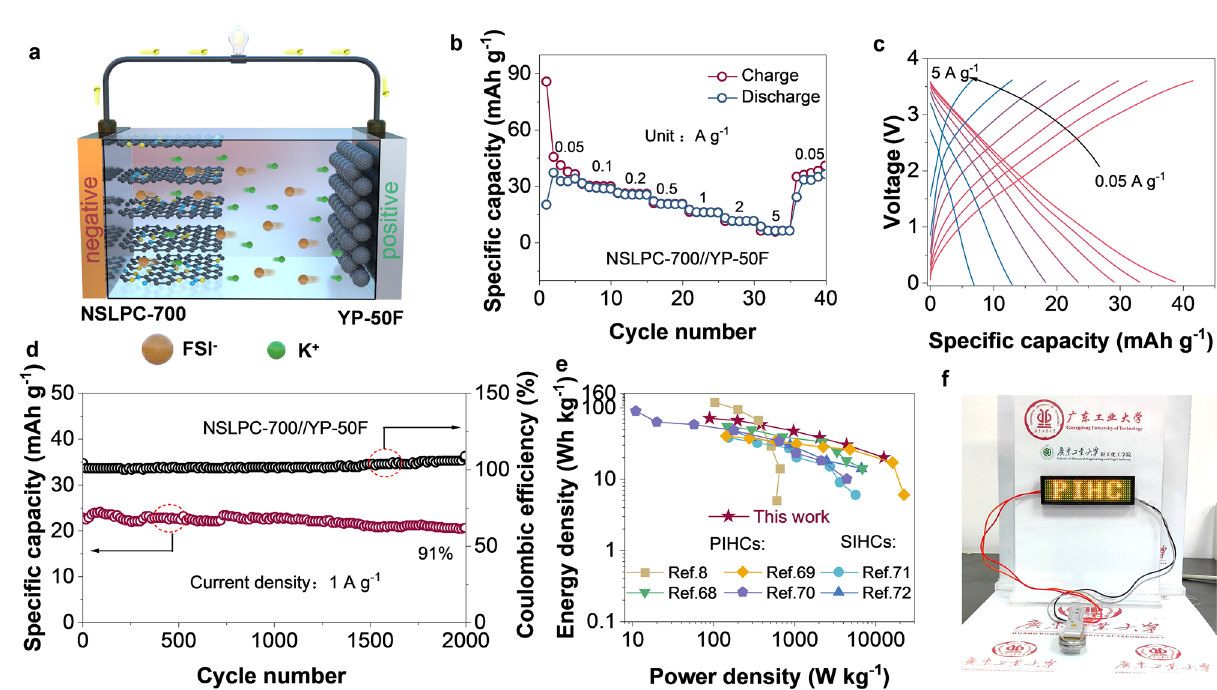
Fig. 8 The performance of PIHC. a Schematic illustrating the configuration of the PIHC (NSLPC-700//YP-50F) device. b Rate performance, and c GCD curves at different current densities. d Long-term cycle performance at 1 A g −1 . e Ragone curves of the NSLPC-700//YP-50F PIHC compared with other PIHC reported recently. f A digital photograph showing an LED bulb is powered by the NSLPC-700//YP-50F